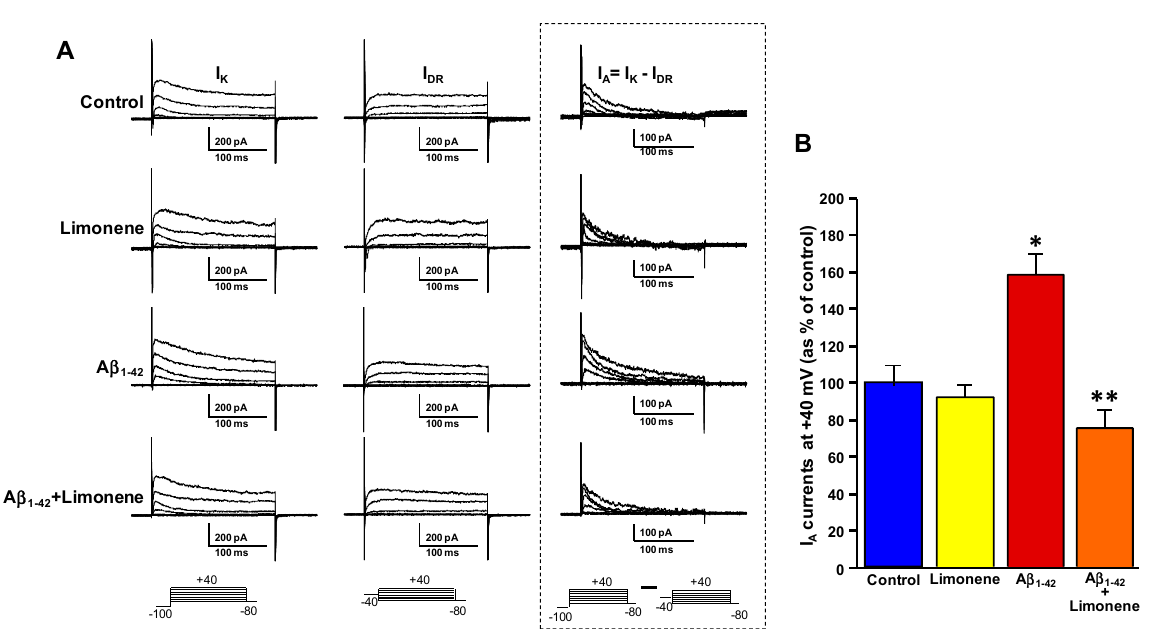
Figure 4. Effects of limonene on K V 3.4 channels in primary rat cortical neurons exposed to A β 1-42 oligomers. ( A ) Representative outward K + currents recorded in primary cortical neurons under control conditions, in neurons treated with limonene (10 µg/mL/24 h), and treated with A β 1-42 oligomers (5 µM/24 h) in the absence and in presence of limonene (10 µg/mL, 30 min pre-treatment). On the left, total K + currents (I K ) elicited by depolarizing steps starting from − 100 mV of increasing voltages are shown. On the middle, the delayed K + currents (I DR ), obtained in the same neurons and elicited by depolarizing steps starting from − 40 mV of increasing voltages are shown. On the right, fast inactivating currents (I A ) carried by K V 3.4, obtained in each cell upon subtraction I K -I DR , are shown. ( B ) Quantification of I A in ( A ). The peak values of I A , measured at the beginning of the +40 mV depolarizing pulse, are expressed as percentage mean ± SEM of three independent experimental preparations ( n = 12 neurons for each group). * p < 0.05 vs controls; ** p < 0.05 vs A β 1-42 .